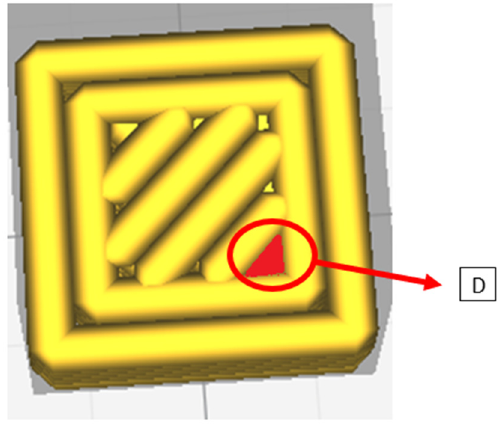
Figure 6. Defect (D).